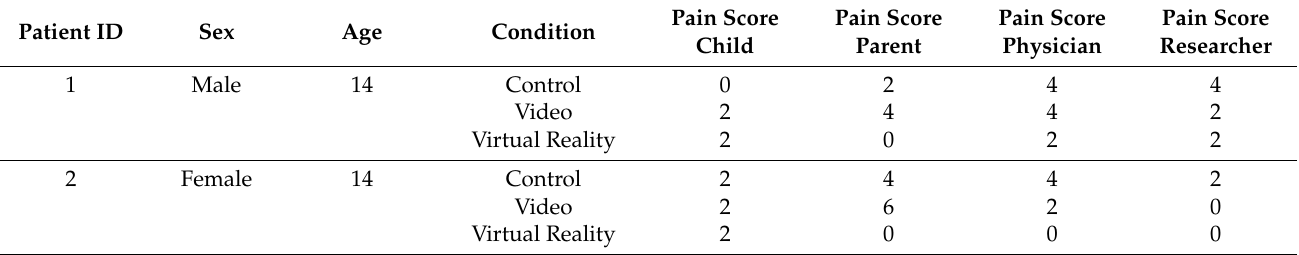
Table 1. Individual pain intensity ratings using the Wong–Baker Faces Scale after a normal re- fill condition, refill with video and refill with virtual reality for children, parents, physician and